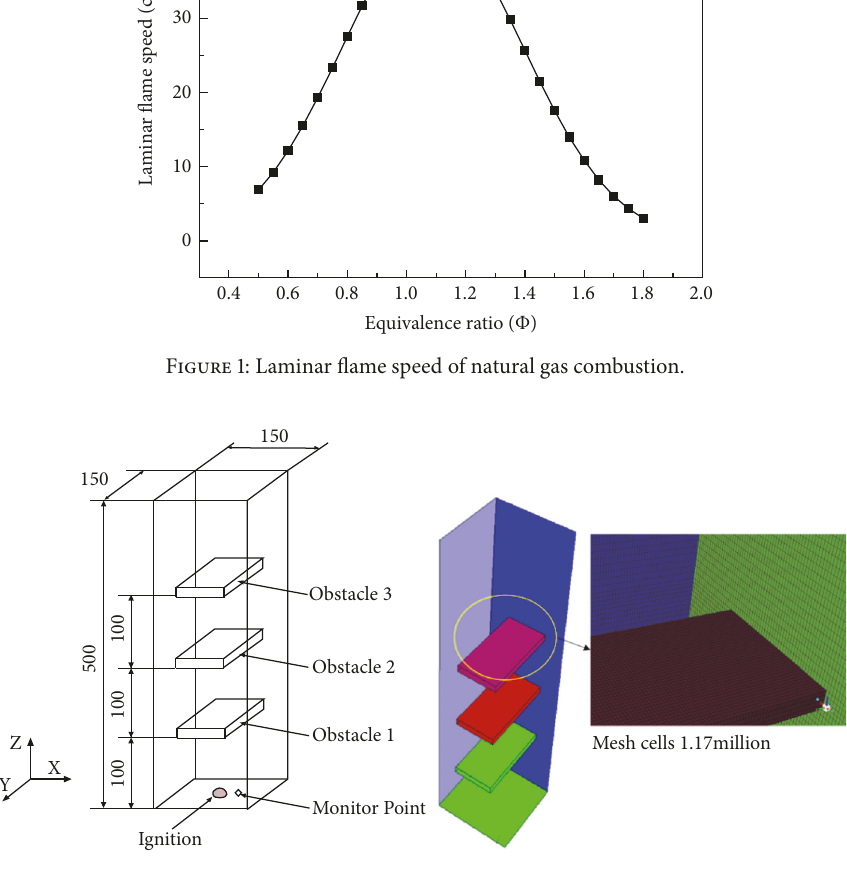
Figure 2: Schematic diagram of the experimental rig (left) and computational mesh